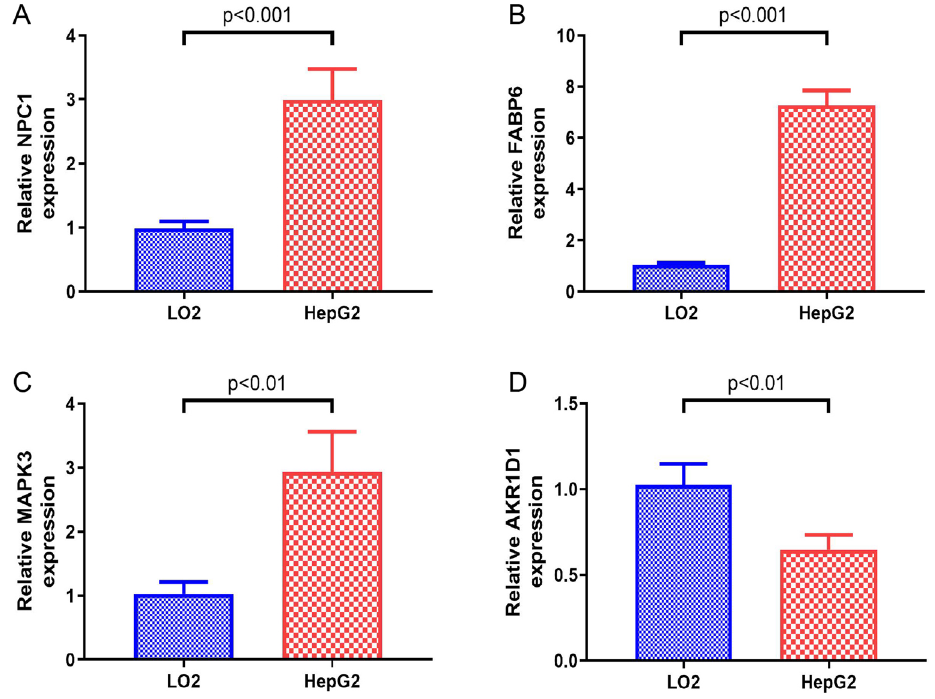
Figure 9. Verification of modeling genes in our cell lines. ( A ) NPC1, ( B ) FABP6, ( C ) MAPK3, ( D )